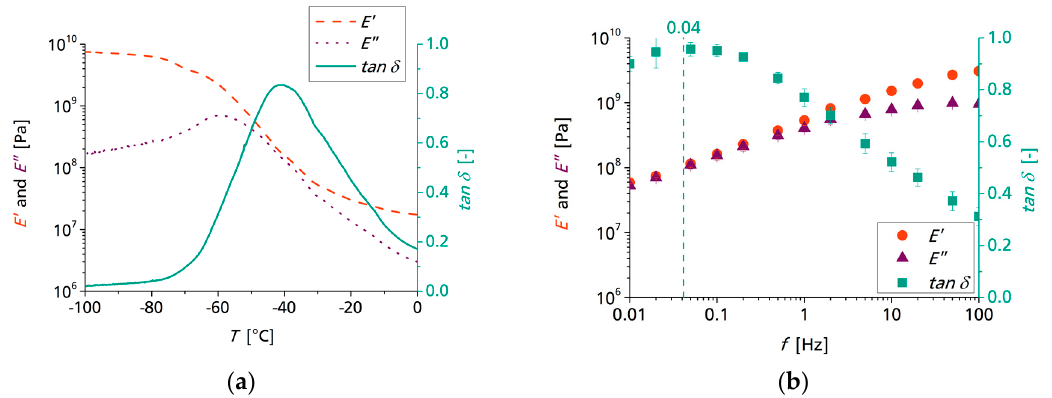
Table 3. Shift factors for reference temperature T 0 = − 50 °C.